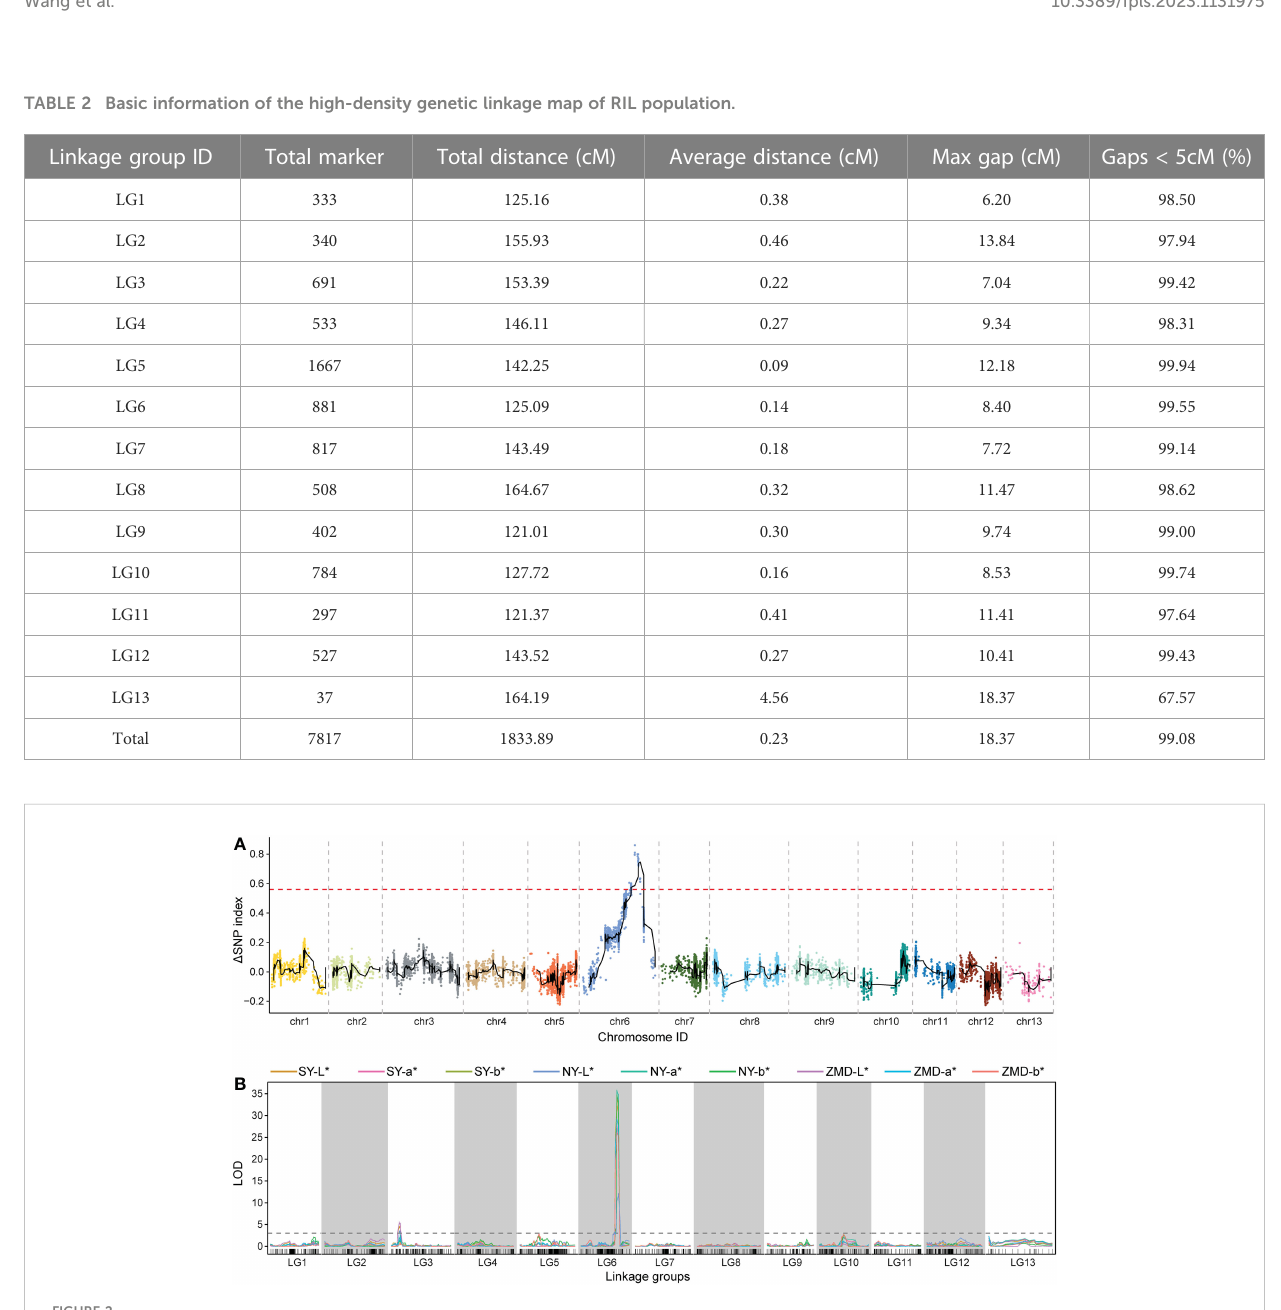
FIGURE 2 QTL identi fi cation across chromosomes and linkage groups using BSA and genetic linkage mapping, respectively. (A) QTL-seq analysis with the number of SNPs as the sliding window, with the red dashed line representing the signi fi cance threshold. (B) QTL scanning of the brown seed coat for the total linkage